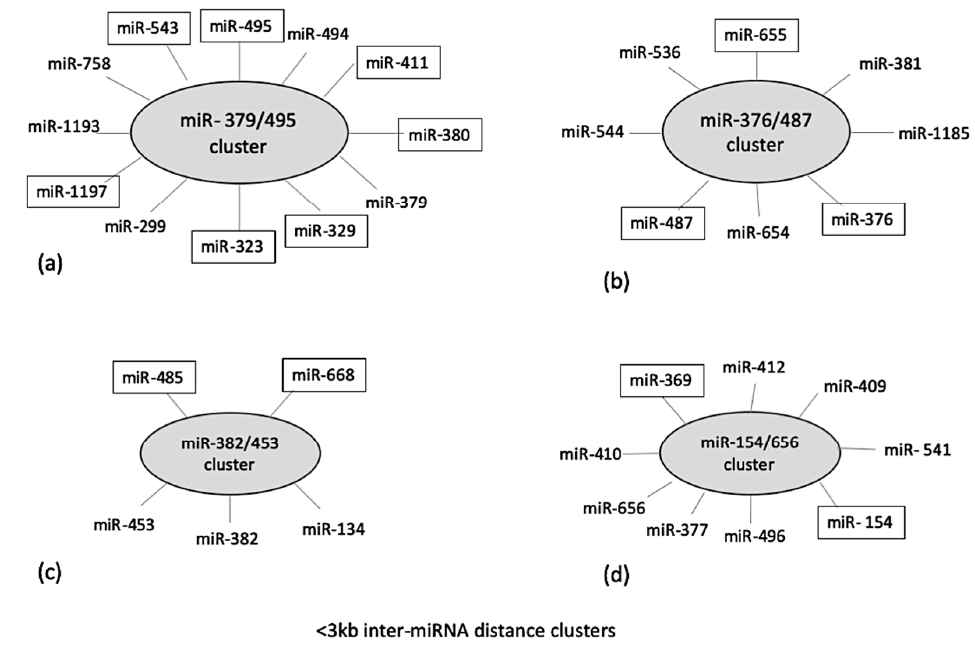
Figure 3. Cluster analysis of identified differentially expressed miRNAs at 4 h post-LPS-challenge, using two different databases: miRbase and MetaMirClust at <3,000 bp inter-miRNA distance. The miRNAs highlighted (in boxes) in given clusters were differentially expressed in the present study. The total length of cluster ( a ) is 11,450 bp; cluster ( b ) is 12,003 bp; cluster ( c ) is 1888 bp; and cluster ( d ) is 6729 bp.